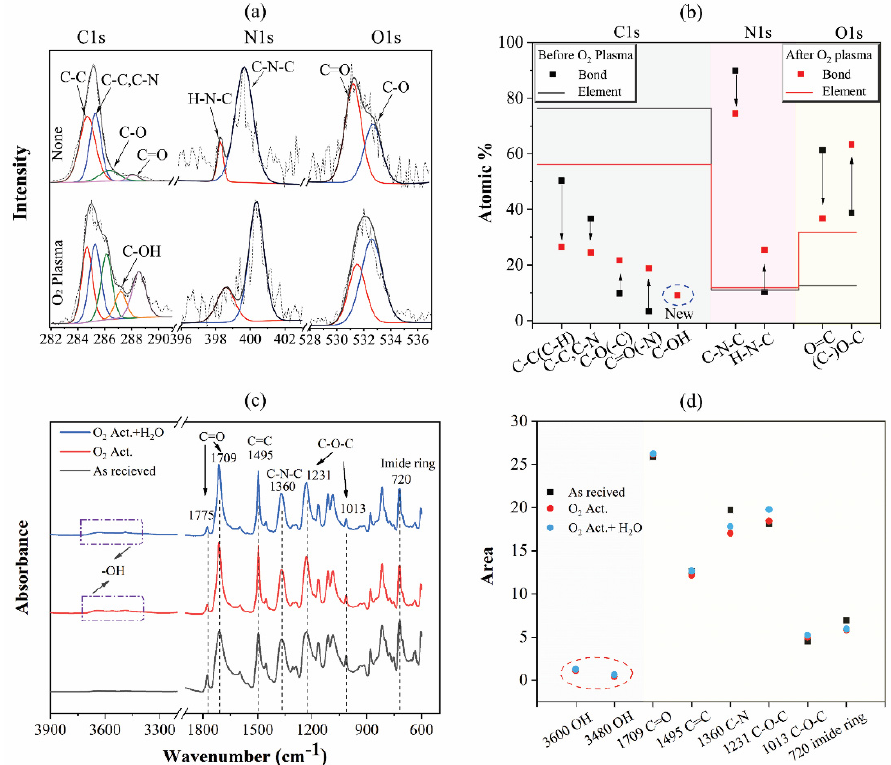
Figure 6. The status of polyimide surfaces before and after the plasma activation: ( a ) C 1s, N 1s, and O 1s core-level XPS spectra; ( b ) the ratio of the functional groups; ( c ) the infrared absorption spectrum obtained via FTIR tests; ( d ) the area of feature functional groups in spectra. Act.: activation.